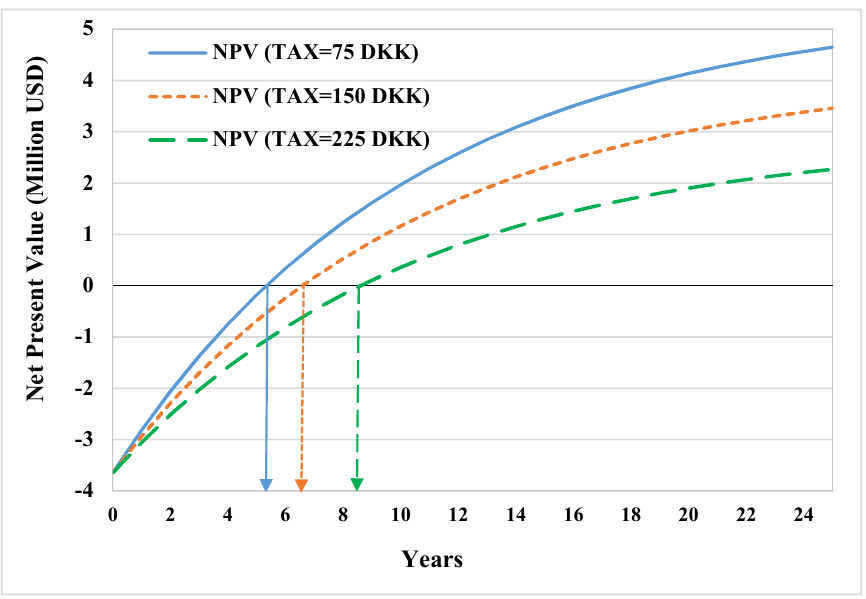
Figure 14. The NPV of the proposed solution over the useful lifetime.